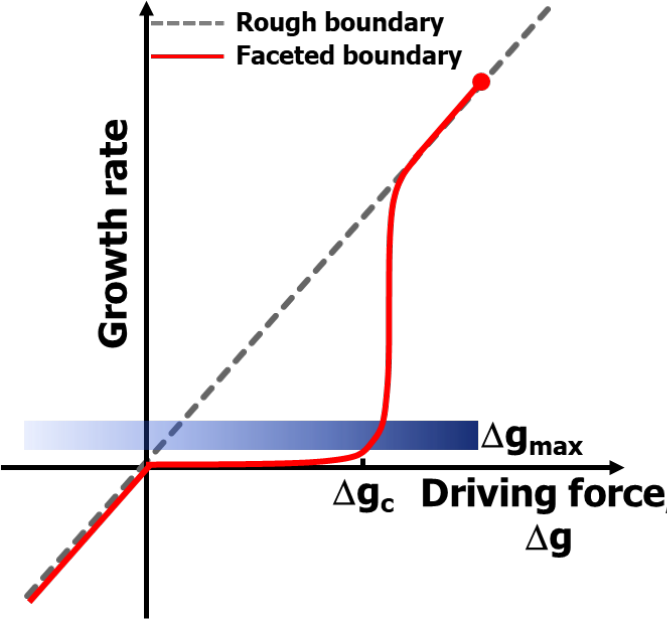
Figure 4. Schematic showing the mixed control model of boundary migration and grain growth [17] (reprinted with permission from Wiley). Δ g max : maximum driving force for the largest grain; and Δ g c : critical driving force for appreciable migration of a faceted boundary.